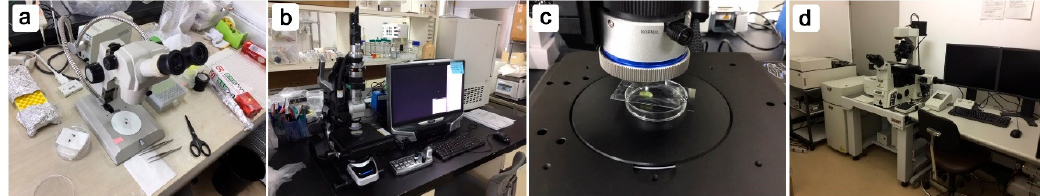
Figure A3. Microscope systems used in this study. ( a ) Conventional dissection stereomicroscope for surgical operations. ( b ) Keyence VHX-6000 digital microscope for bright-field observations. ( c ) A live butterfly sample set at the Keyence system. ( d ) Nikon A1 + inverted confocal laser microscope for fluorescent observations.